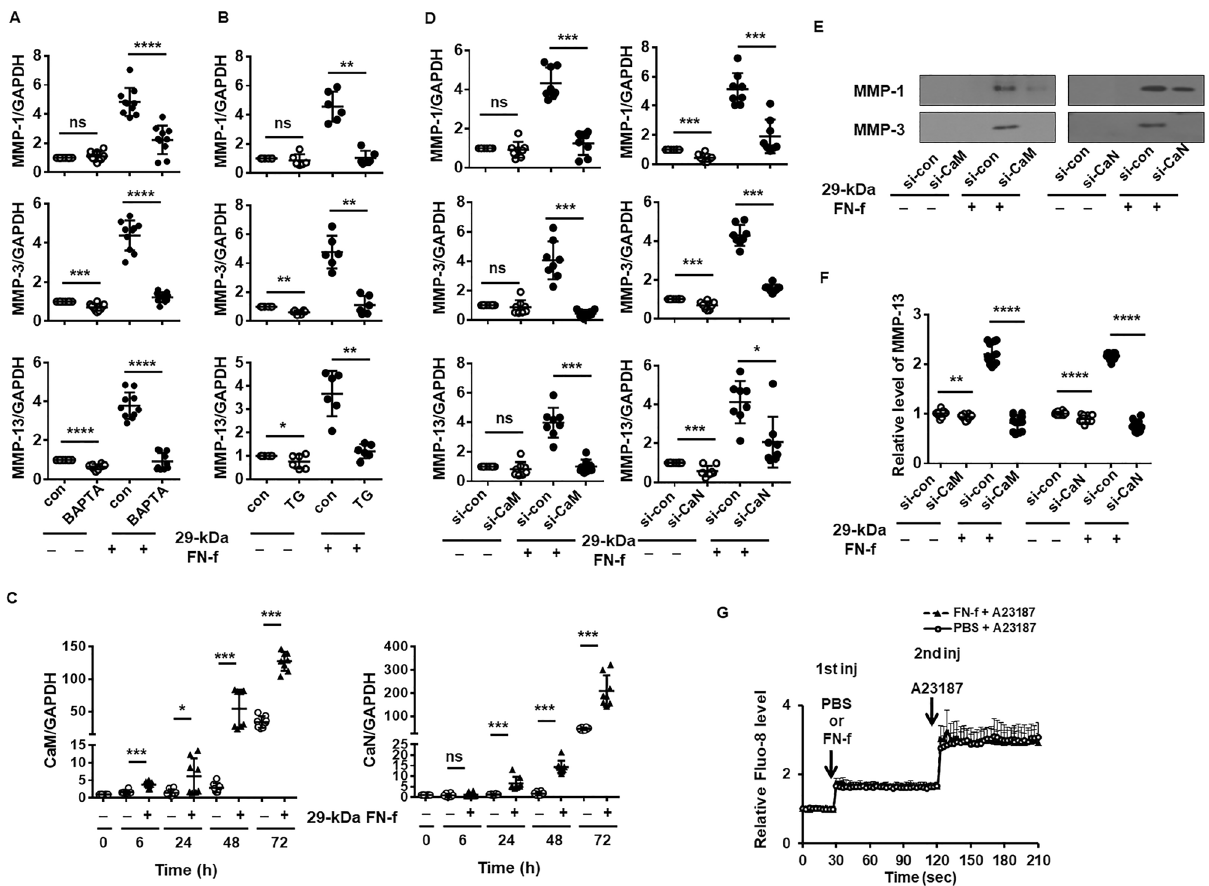
Figure 7. 29-kDa FN-f induces MMP expression via the CaN-dependent signaling pathway. ( A , B ) Depletion of the intracellular calcium concentration reduced MMP expression by 29-kDa FN-f. Chondrocytes were pretreated with ( A ) BAPTA, a calcium chelator, and ( B ) TG, an inhibitor of the sarcoendoplasmic reticulum Ca 2+ ATPase (SERCA) for 2 h and then incubated with 29-kDa FN-f for 6 h. Data are expressed as the mean ± SD of duplicate data from more than three independent donors (n ≥ 3). P- values represent comparisons between two groups. * P < 0.05, ** P < 0.01, *** P < 0.001, and **** P < 0.0001 vs. BAPTA- or TG-untreated cells; ns, not significant. ( C ) 29-kDa FN-f affected CaM and CaN expression. Cells were treated with 29-kDa FN-f for 6, 24, 48, and 72 h. The levels of CaM and CaN were measured by QuantiFast SYBR Green qRT-PCR. Data are expressed as the mean ± SD of duplicate data from four independent donors. * P < 0.05 and *** P < 0.001 vs. untreated control; ns, not significant. ( D ) Knockdown of CaM and CaN reduced MMP expression induced by 29-kDa FN-f. Chondrocytes were incubated with si-CaM and si-CaN for 48 h, followed by treatment with 29-kDa FN-f for 6 h. Expression levels of MMPs 1, 3, and 13 were measured by QuantiFast SYBR Green qRT- PCR. Data are expressed as the mean ± SD of duplicate data from four independent donors (n = 4). P- values represent comparisons between two groups. ( E , F ) The protein levels of MMPs 1, 3, and 13 in culture medium from 29-kDa FN-f-stimulated chondrocytes were measured by ( E ) western blot and ( F ) ELISA. The western blot shown is representative of blots from three independent donors (n = 3). * P < 0.05, ** P < 0.01, *** P < 0.001, and **** P < 0.0001 vs. si-con-treated control; ns, not significant. ( G ) 29-kDa FN-f induced no change in the intracellular Ca 2+ concentration. Chondrocytes were pretreated with Fluo-8 dye loading solution for 30 min at 37 °C and then incubated for 30 min at room temperature, followed by the first injection of 29-kDa FN-f (300 nM). The fluorescence intensity was monitored at 490/525 nm for 90 s using a Synergy Mx microplate reader. Then, A23187 ionophore was injected into the cells, followed by monitoring the fluorescence intensity for 90 s. Data are expressed as the mean ± SD of triplicate data from two independent experiments. ( A – D ) and ( F , G ) The figures were analyzed and produced by GraphPad Prism software (GraphPad Prism 6.07; https:// www. graph pad. com/ scien tific- softw are/